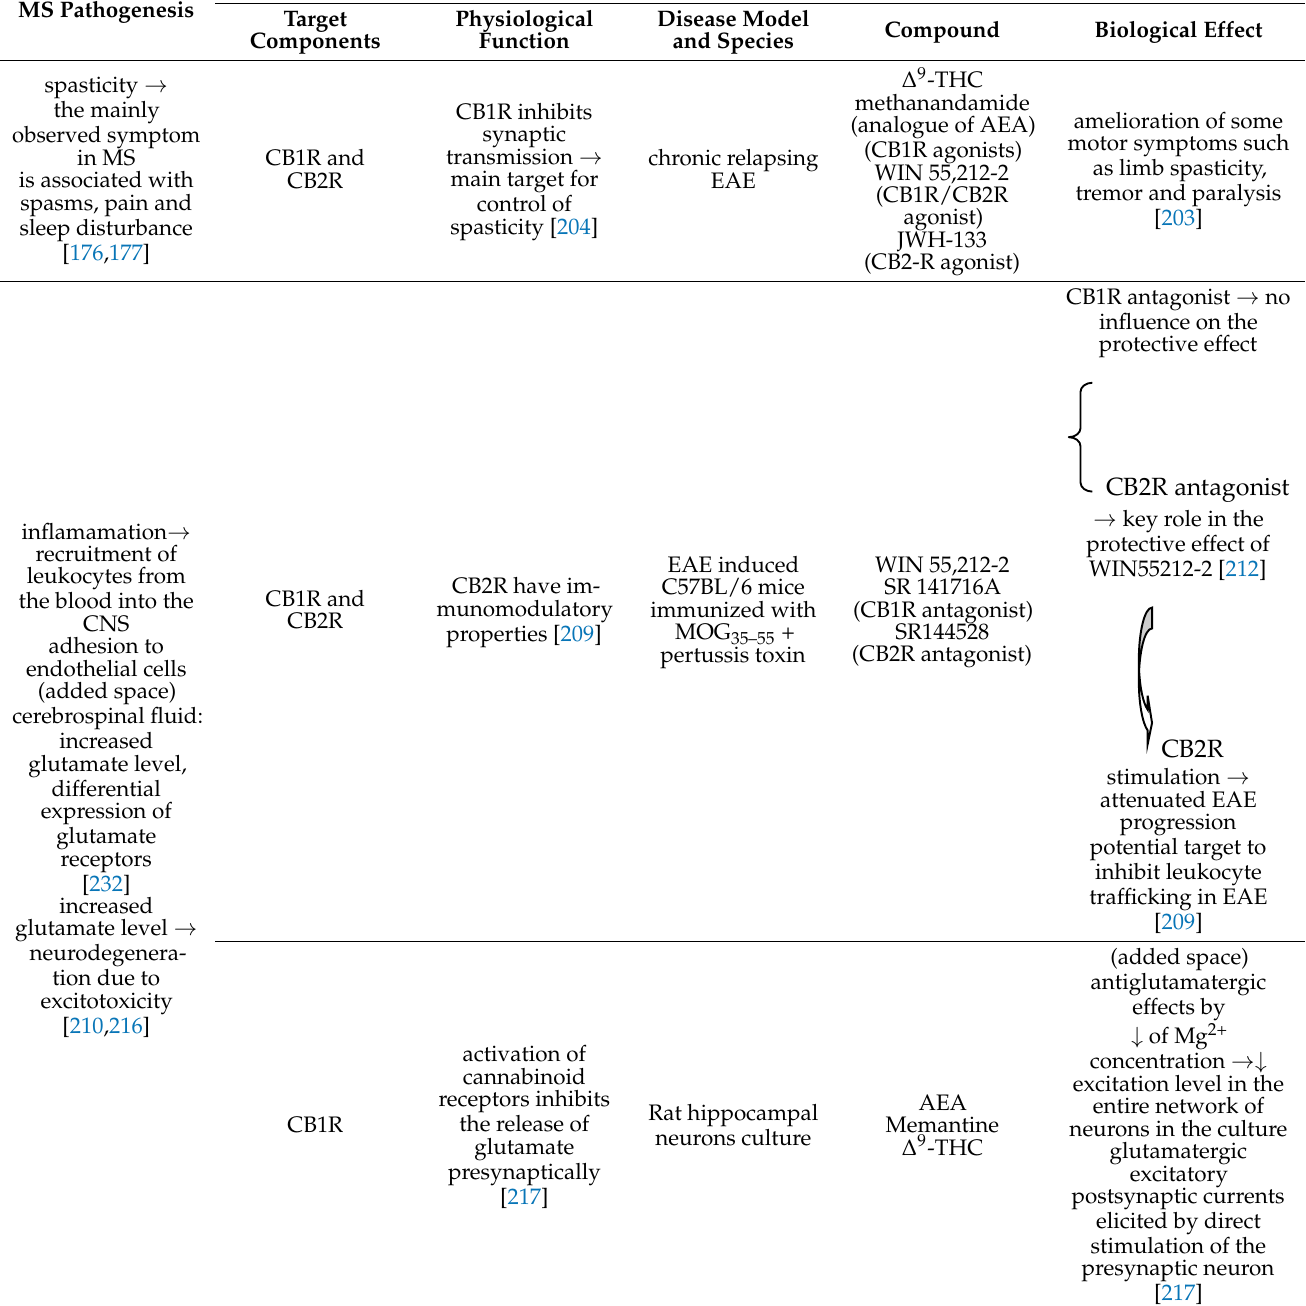
Table 4. Implications of ECS in various pathological aspects of MS; ↓ : decrease; ↑ = increase.